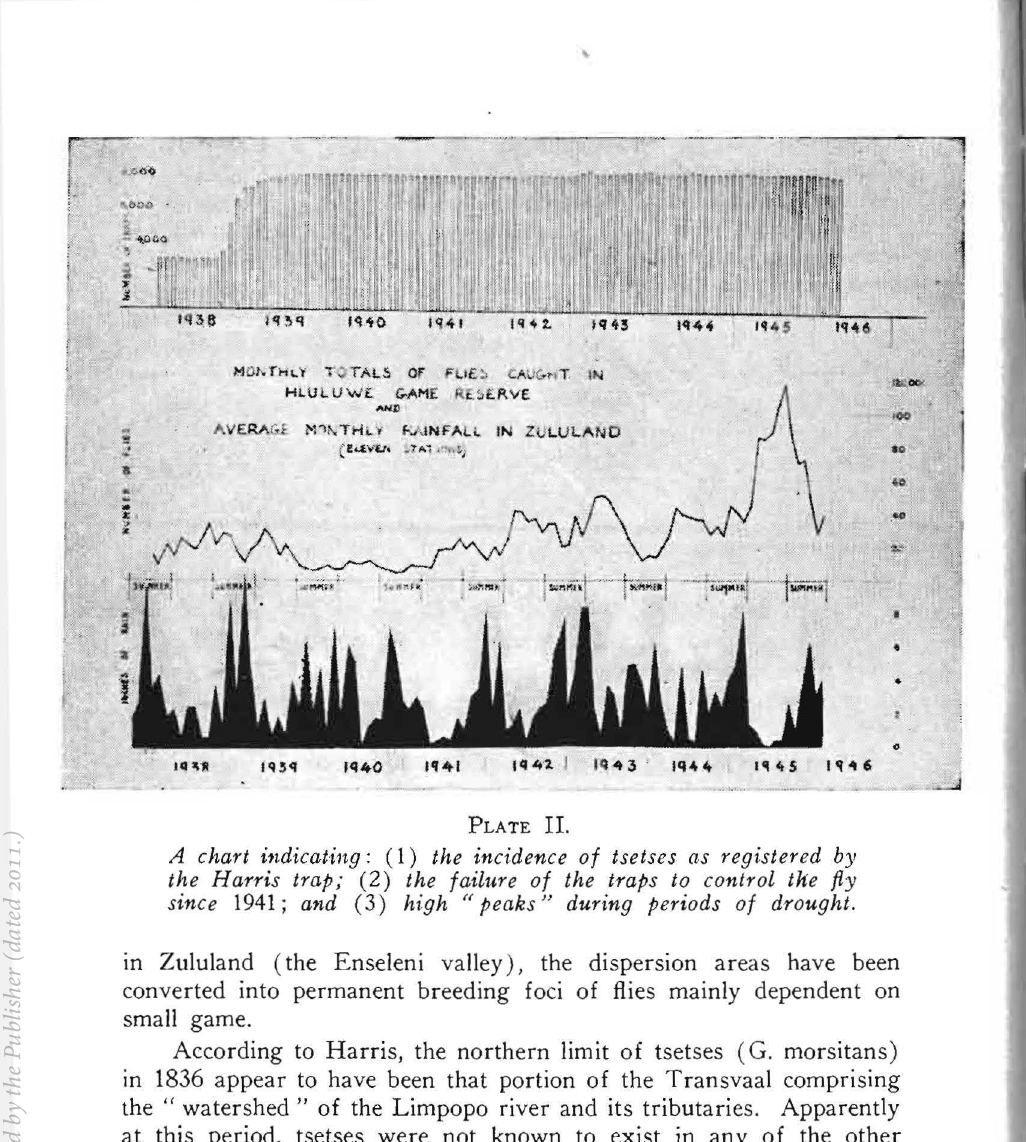
A chart itldicating: (1) the incidence of tsetses as registered by the Harris trap,' (2) the fail1tre of the traps to control the fly since 1941; and (3) high "peaks " during periods of